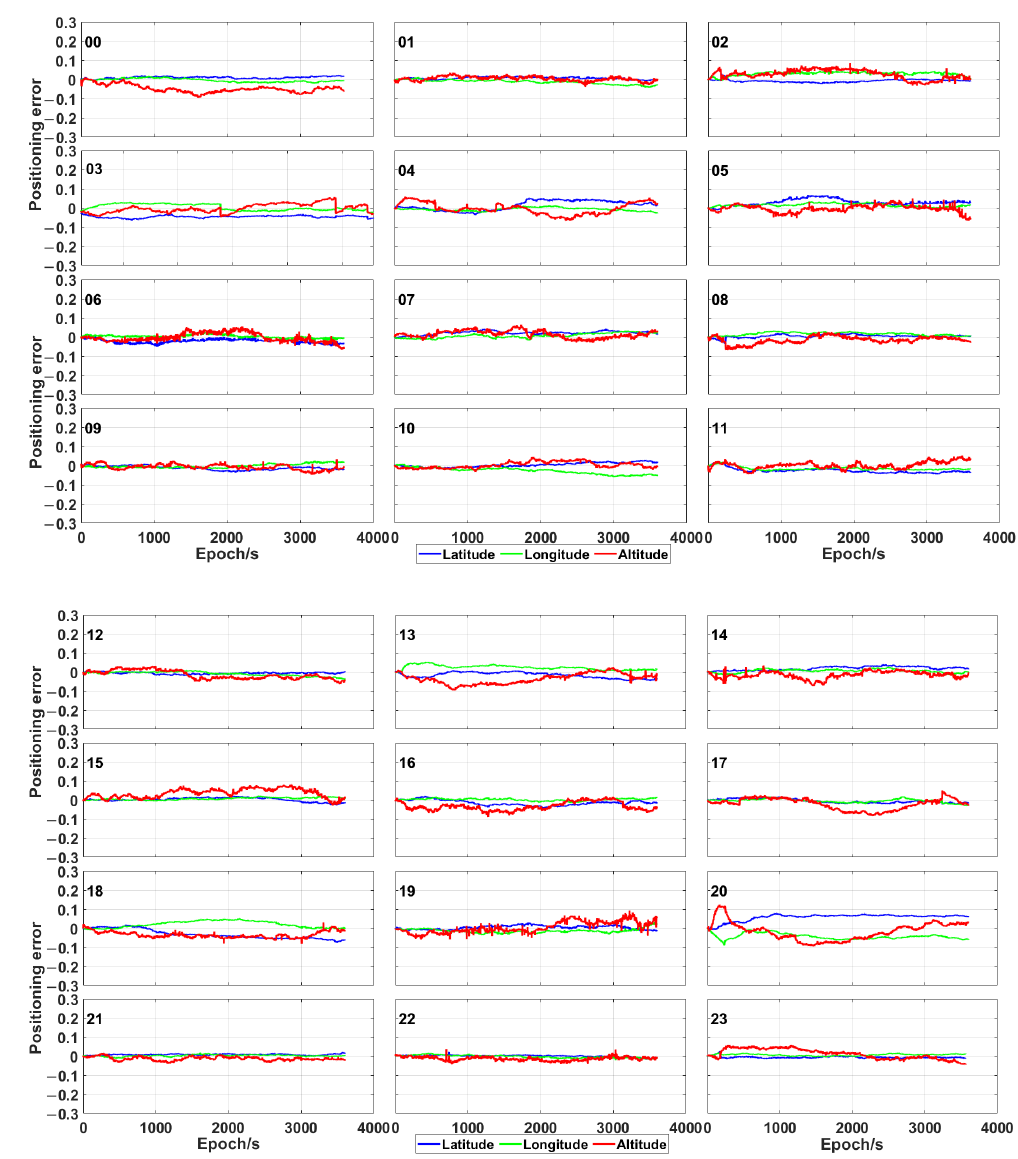
Figure 6. Positioning error (expressed in metres) obtained by means of the proposed time-relative positioning method by using GPS, Galileo and BeiDou at different hours.